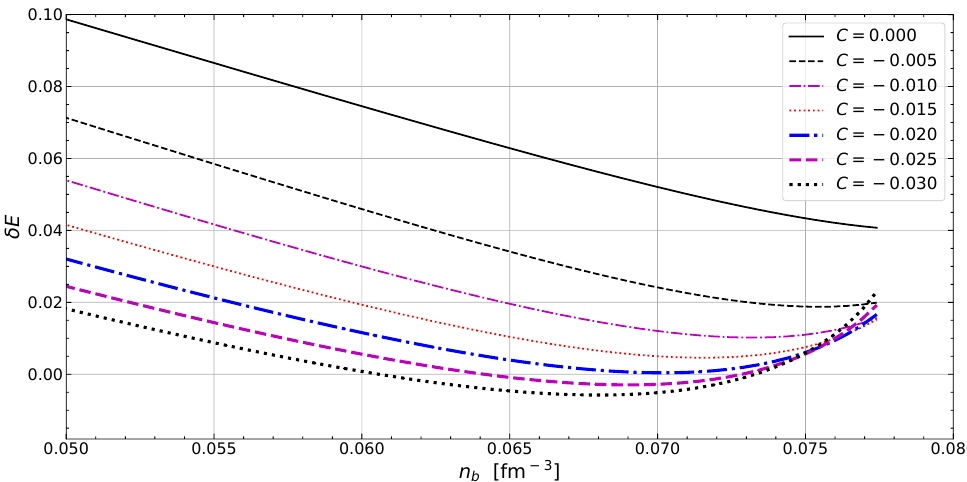
Figure 2. δ E normalized to Z 2 e 2 ε 2 / R as a function of nucleon number density for different values of C = µ N / µ n . The neutron skin effects are included within CLDM of Ref. [26]. SLy4 potential [16,17] is